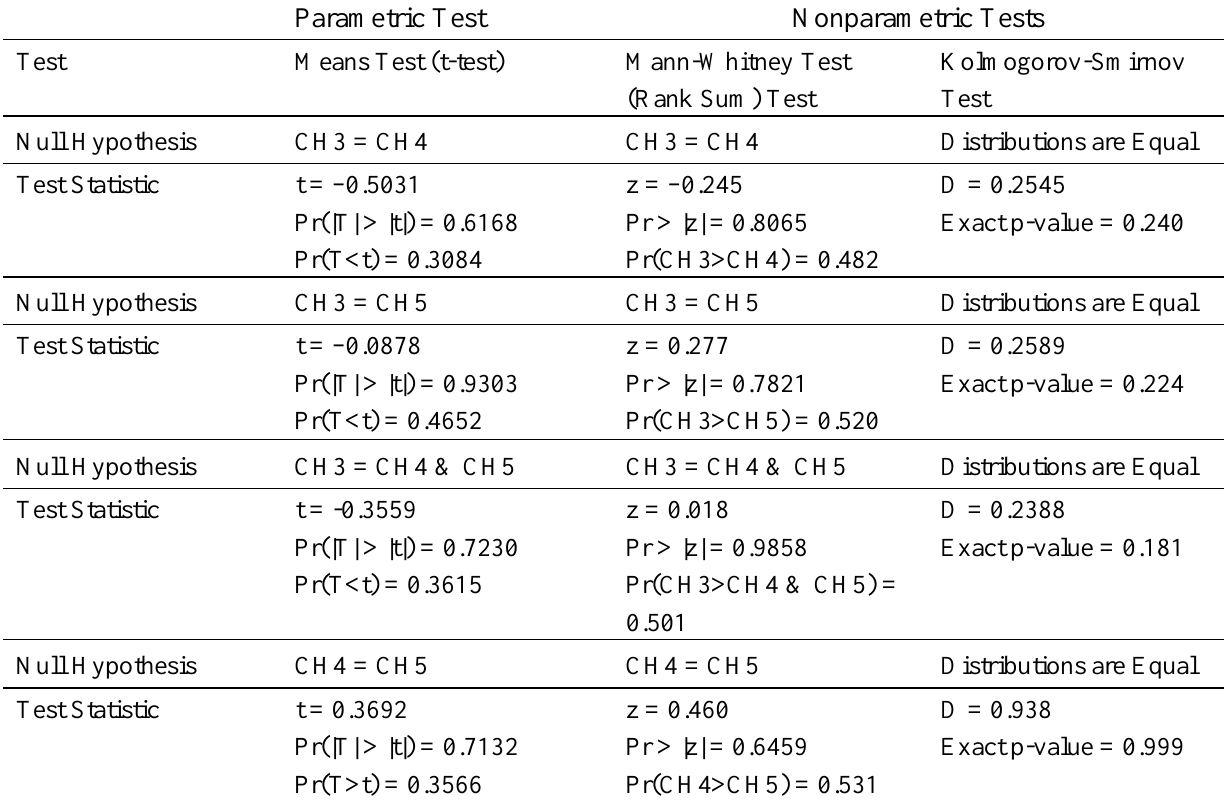
Table A7. Parametric and non-Parametric tests of Type X data for CH3, CH4, and CH5.